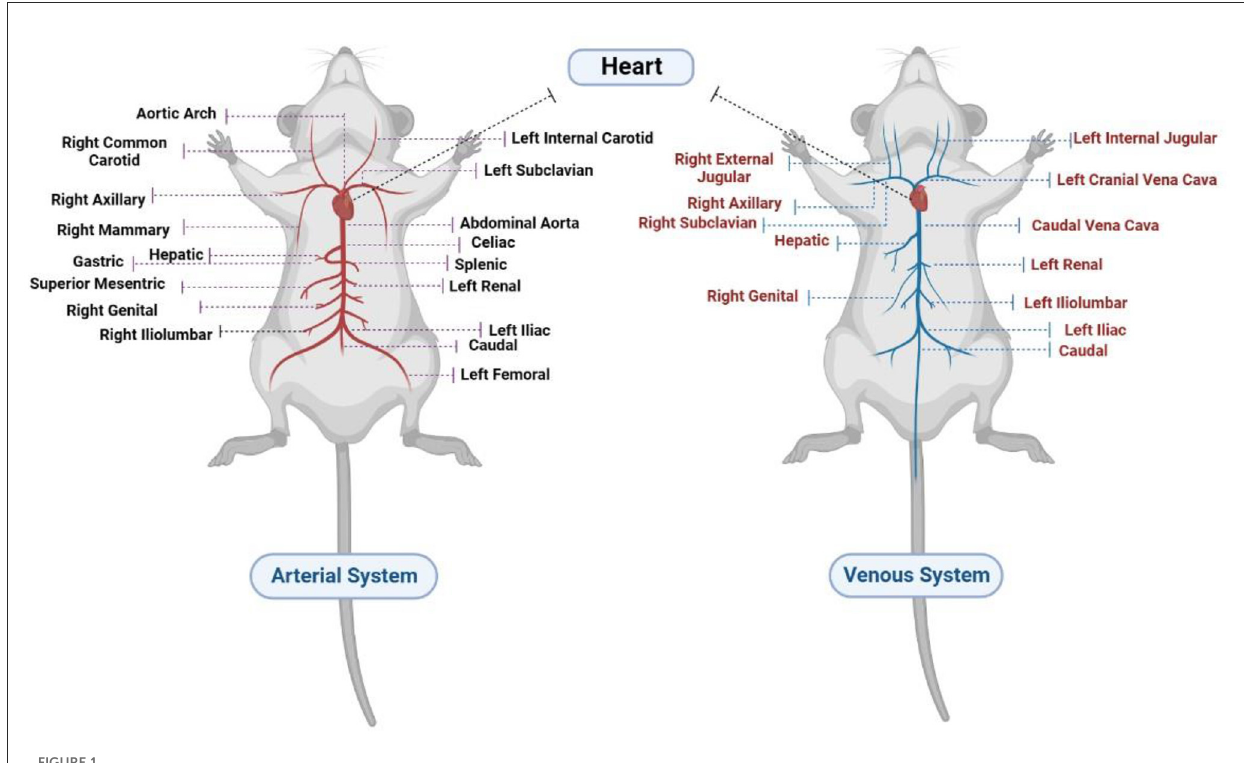
FIGURE1 Circulatory system in rats.